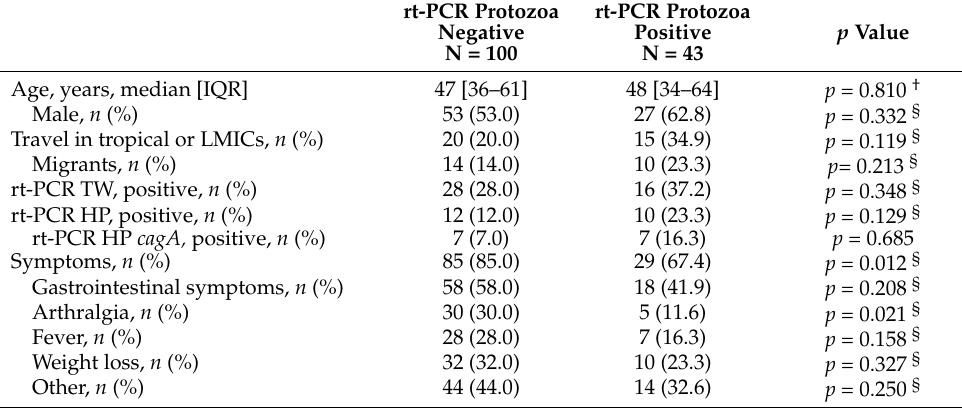
Table 4. Demographic data, risk factors, rate of infections (TW and HP), and symptoms of 143 patients, according to the results of the rt-PCR for the detection of at least one protozoan. TW, T. whipplei ; HP, H. pylori ; LMICs, low- and middle-income countries; IQR, interquartile range. rt-PCR Protozoa rt-PCR Protozoa Negative Positive p Value N = 100 N = 43 Age, years, median [IQR] 47 [36–61] 48 [34–64] p = 0.810 † Male, n (%) 53 (53.0) 27 (62.8) p = 0.332 § Travel in tropical or LMICs, n (%) 20 (20.0) p = 0.119 § Migrants, n (%) 14 (14.0) rt-PCR HP, positive, n